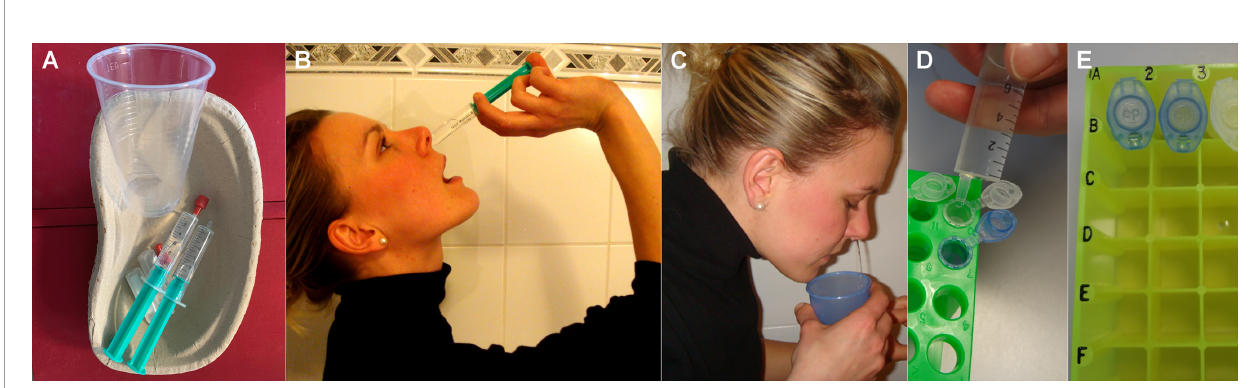
FIGURE 1 | (A – C) Method to sample NL- fl uid rinsing 10 mL of isotonic saline through each nasal side while closing the soft palate. (D, E) home-based aliquotation into disposed reaction tubes, containing 15 µL of protease inhibitor, before